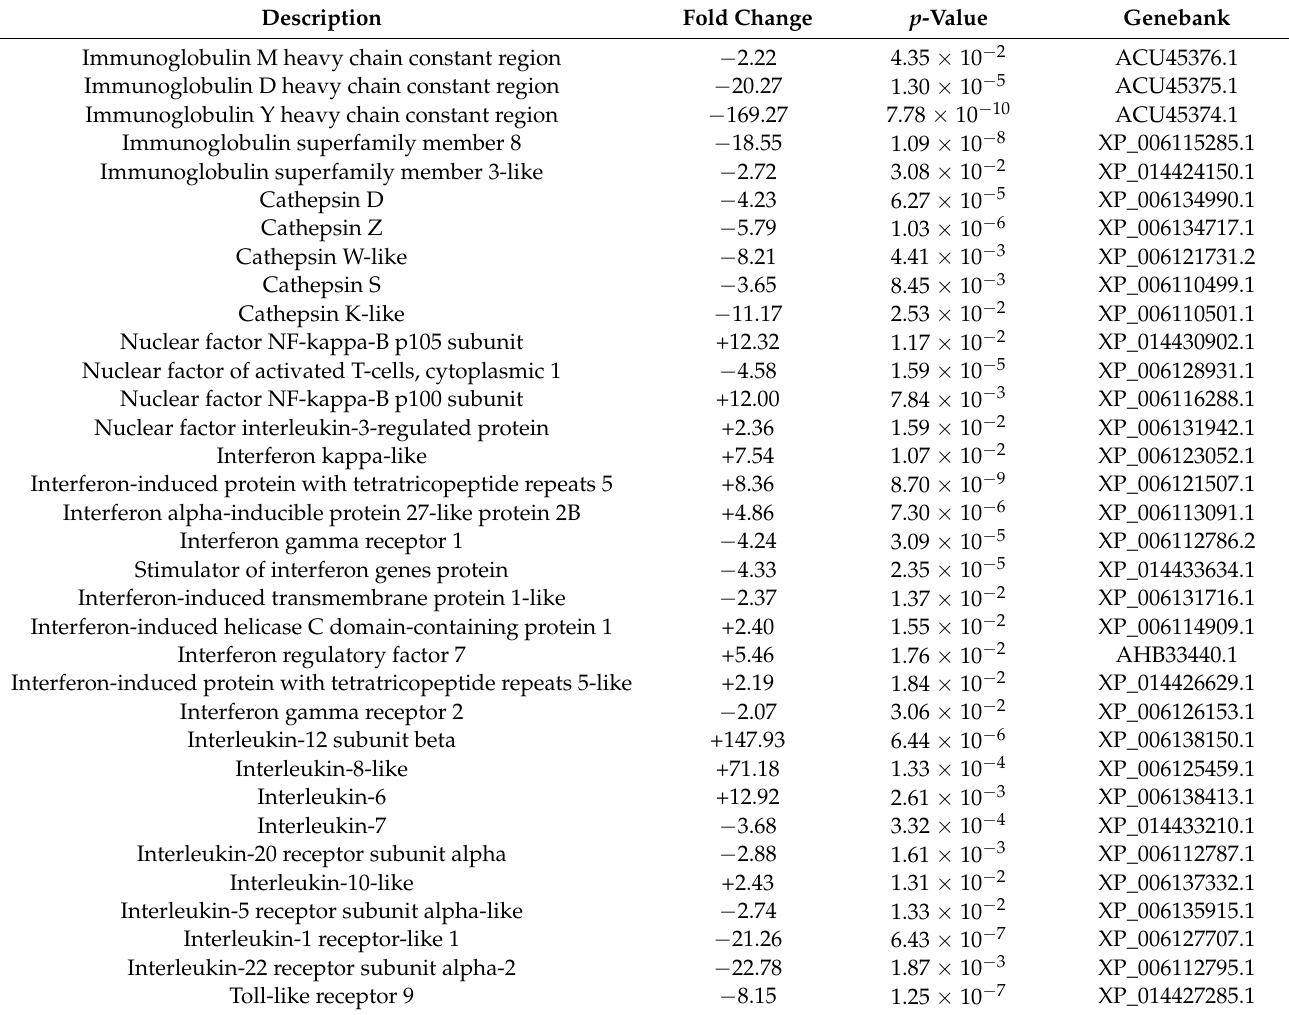
Figure 5. Statistical overview of DEGs. Each red dot represents a significantly upregulated gene, each blue dot represents a significantly downregulated gene, and each gray dot represents a non-significant differential gene. ( a ) Volcano plot of DEGs. The two vertical dashed lines indicate a fold change threshold of more than 2.0, while the horizontal dashed line indicates a p -value threshold lower than 0.05. ( b ) MA plot of DEGs. The X-axis represents the logarithm base 2 of the product of the gene expression in the two groups, while the Y-axis represents the logarithm of the fold change (base = 2). Table 7. Information of immune-related DEGs in response to B. cereus